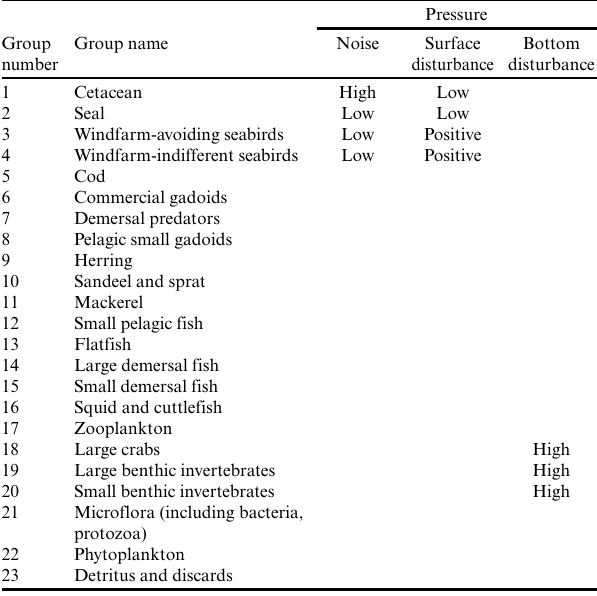
Table 4. Functional responses by pressure (noise, surface disturbance, bottom disturbance) as assigned for each group in the ecosystem, at initial